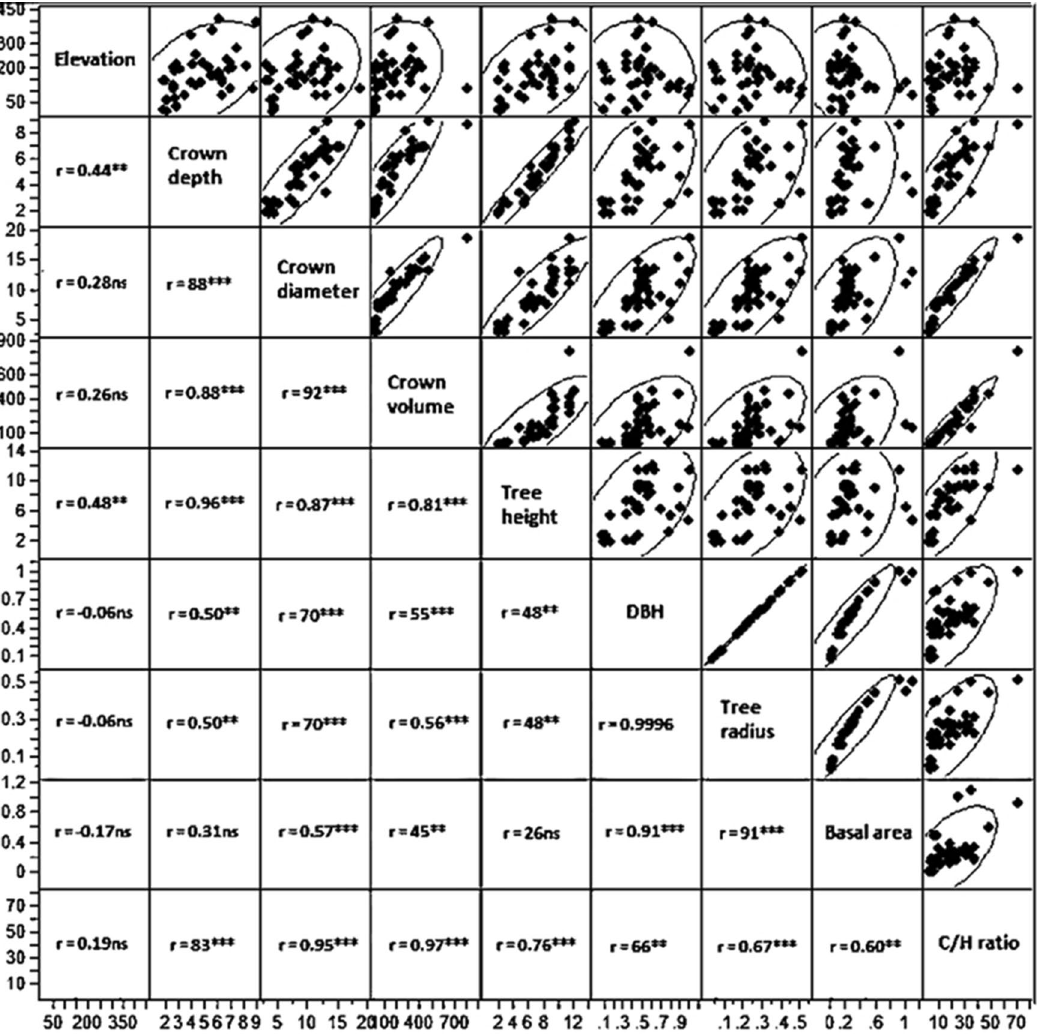
Figure 6. Scatter matrix of correlation coefficients of elevation and Vachellia tree characteristic parameters in wadi Khoda and wadi Rahaba, Gebel Elba National Park, southeastern